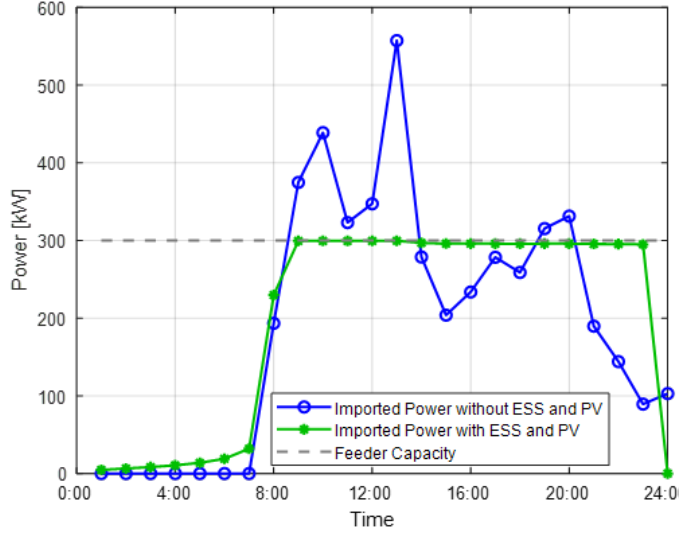
Figure 11. Imported power of XFC4 on a winter ’s day.